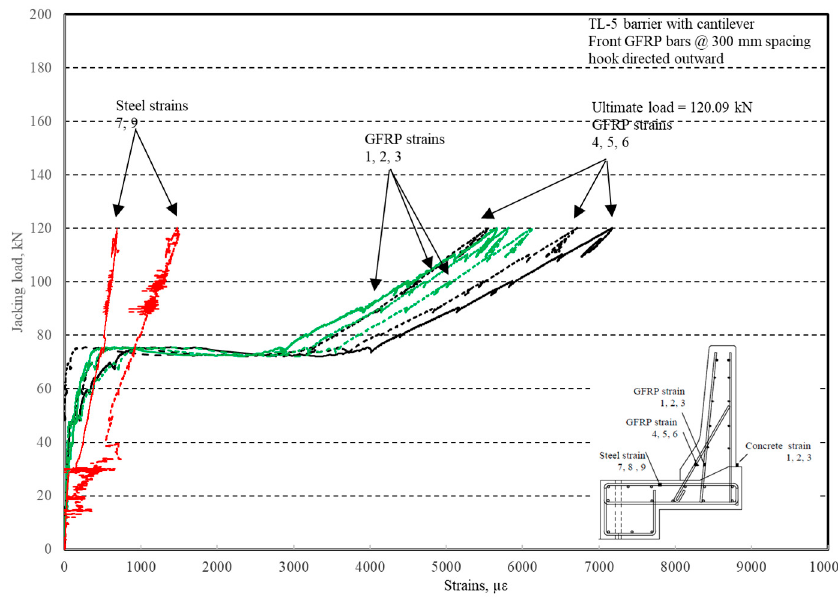
Figure 16. Specimen # 2: Load vs. bar strain history.